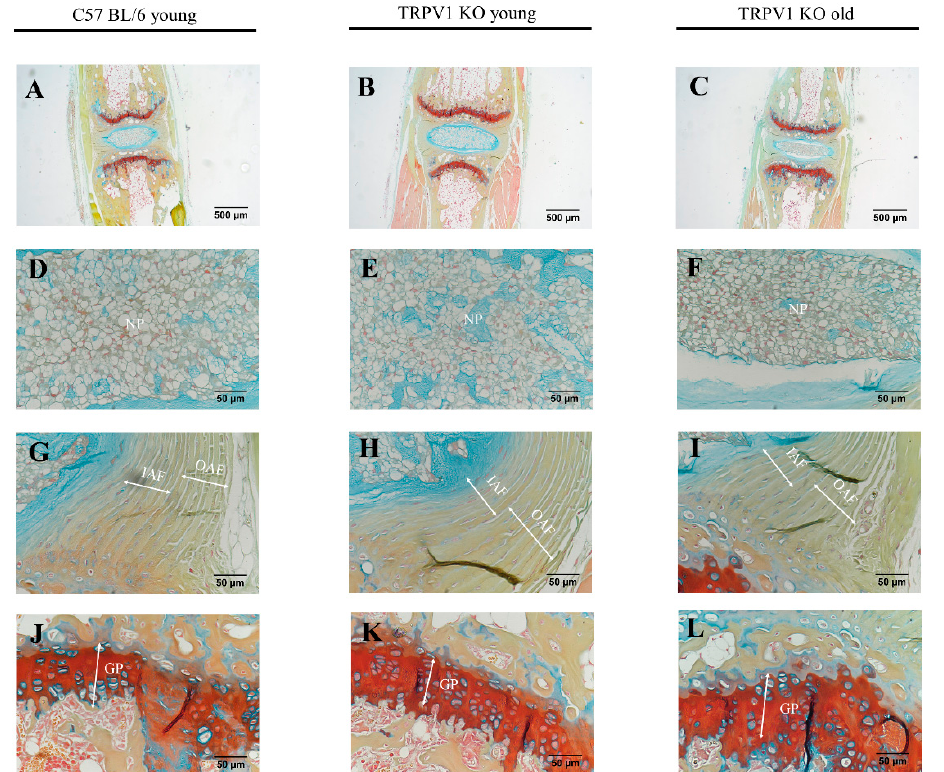
Figure 8. FAST staining of IVDs of TRPA1 WT and TRPV1 KO mice. The tail motion segments of C57 BL/6 young WT ( A , D , G , J ), TRPV1 young KO ( B , E , H , K ), and TRPV1 old KO ( C , F , I , L ) mice. The nucleus pulposus: NP ( D – F ); inner annulus fibrosus: IAF and outer annulus fibrosus: OAF ( G – I ); and, vertebral growth